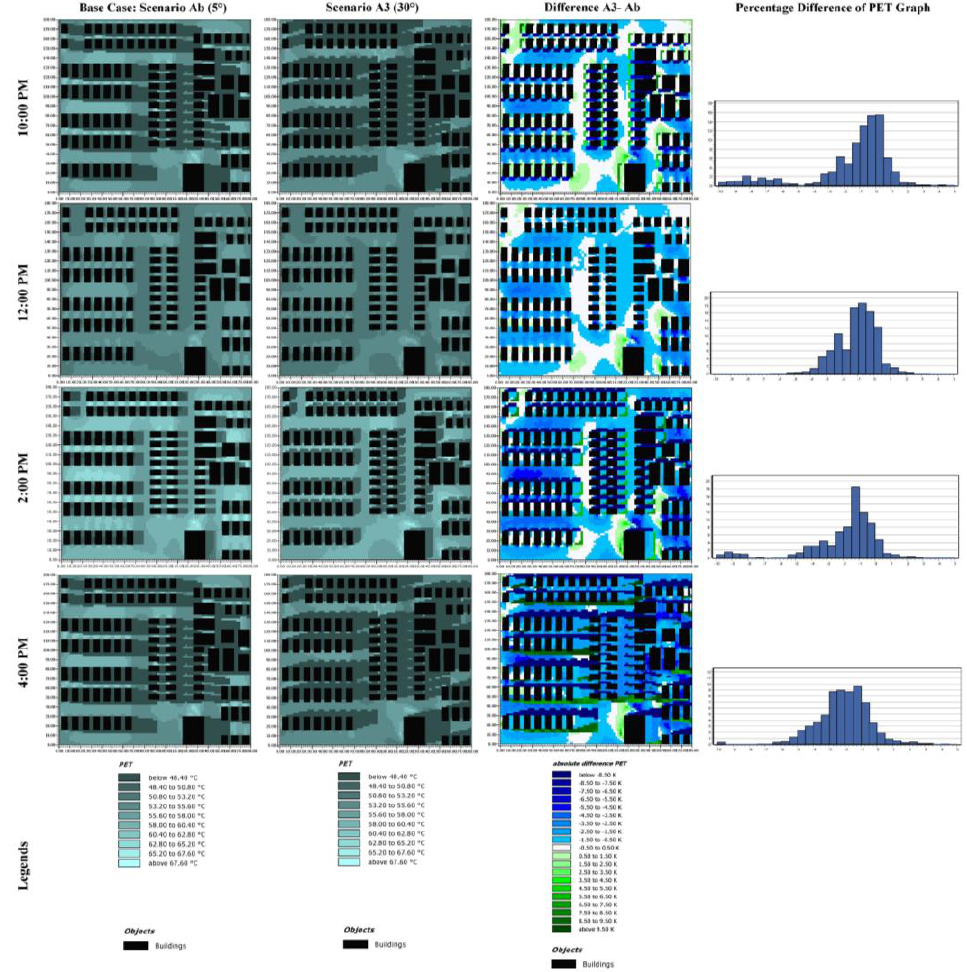
Fig. 5. Temporal variation of